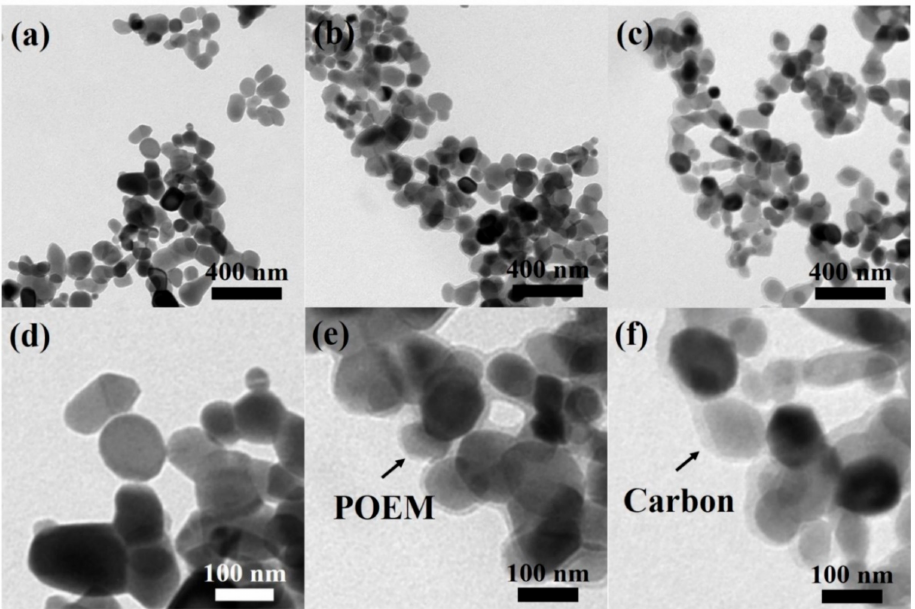
Figure 1. TEM image of ( a ) ZrO 2 , ( b ) ZrO 2 - g -POEM, ( c ) ZrO 2 -C, ( d ) magnified ZrO 2 , ( e ) magnified ZrO 2 - g -POEM, and ( f ) magnified ZrO 2 -C.